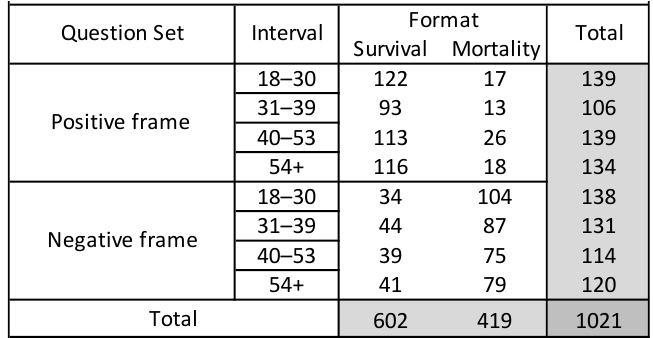
Figure 2: Respondent Totals by Age).